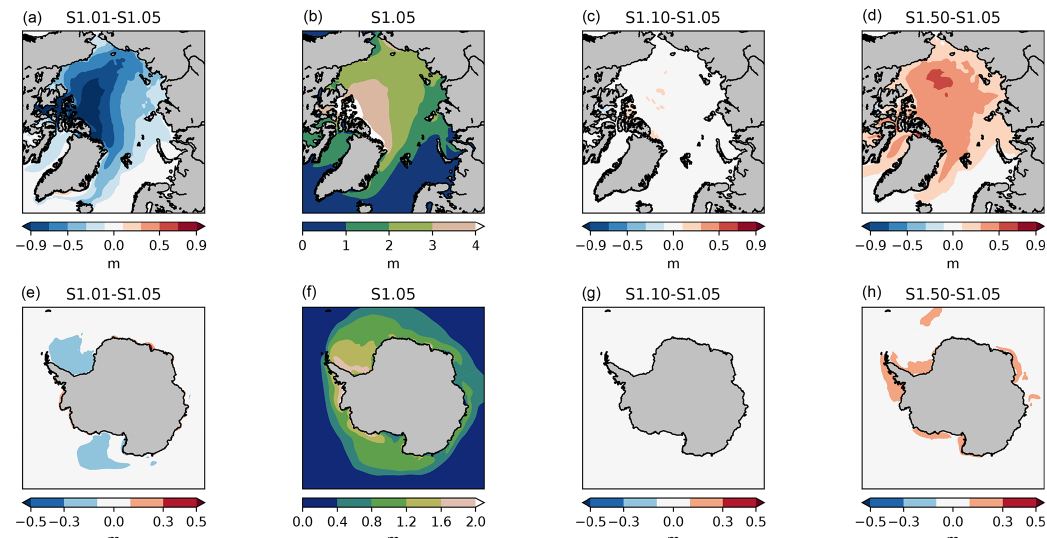
Figure 3. Effective sea ice thickness (grid-cell ice volume divided by grid-cell area) in the Arctic in March (top) and in the Antarctic in September (bottom), averaged over 1995–2014. Experiment S1.05 and differences with selected experiments of the first set are